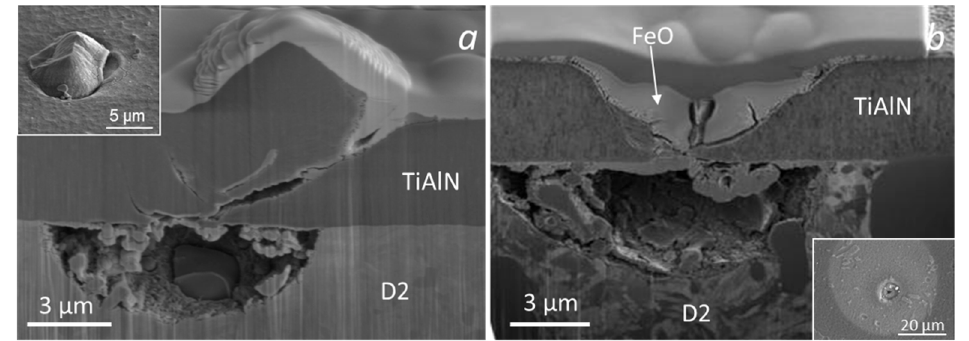
Figure 29. SEM top view (inset) and FIB images of a nodular defect ( a ) and a pinhole ( b ) in the sputter-deposited TiAlN hard coating exposed to corrosion medium (0.5 M NaCl; pH = 3.8, 96 h). An intensive pitting corrosion occurred at both sites.